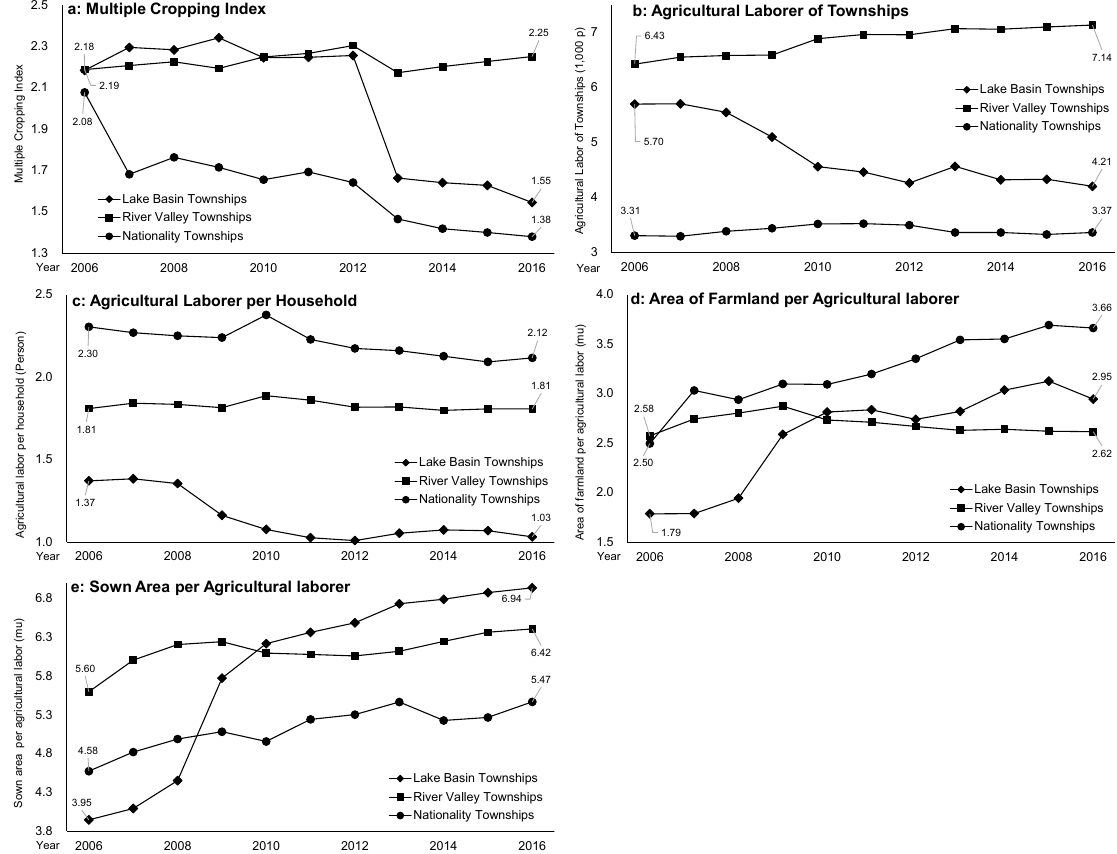
Figure 9. Multiple cropping index, agricultural labor, farmland and sown area in the township zones.